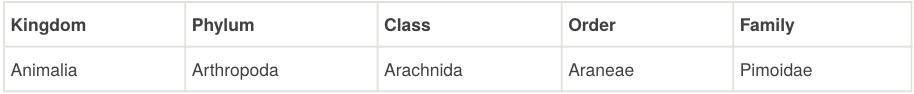
Map of records (image):